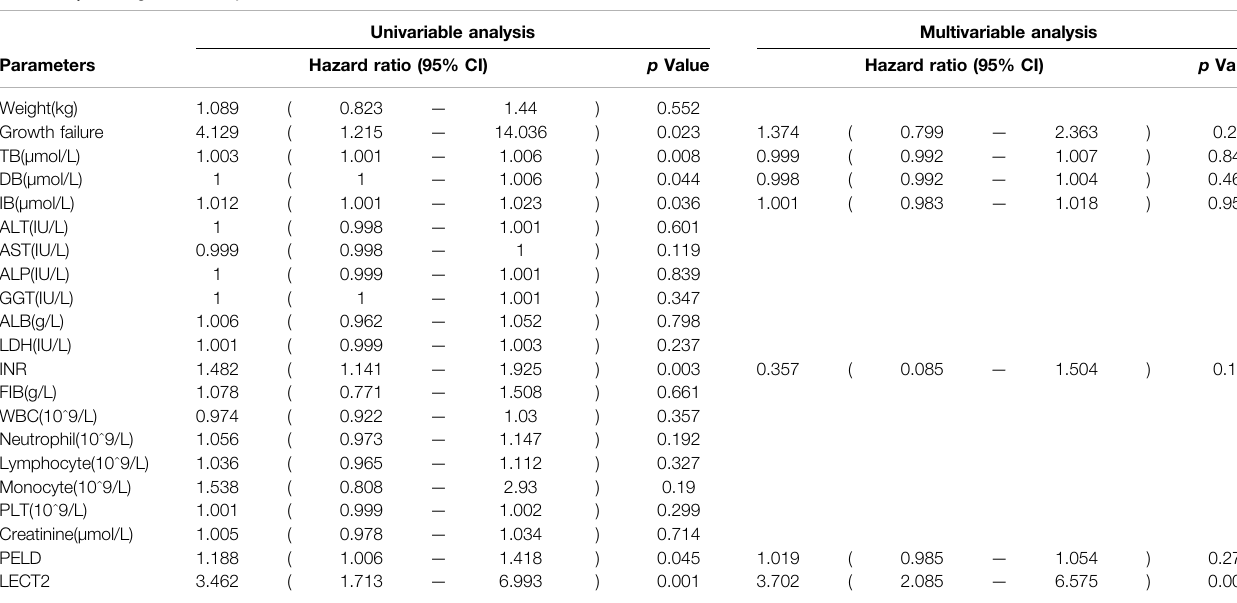
TABLE 3 | Cox regression analysis of native liver survival.